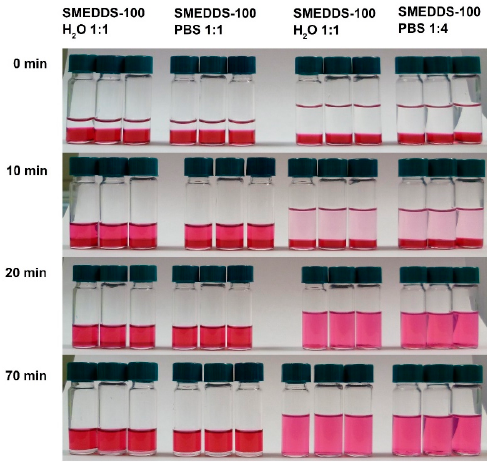
Figure 3. Self-microemulsifying properties of SMEDDS-100, dyed with Sudan Red, overlaid with distilled water or PBS at 1:1 or 1:4 ratios. The experiment was conducted with gentle shaking at 25 °C. Polarized light microscopy investigations of the SMEDDS-100 interface with PBS indicated the formation of an ordered lyotropic liquid crystalline phase that disappeared with further mixing of the two components (Figure 4).